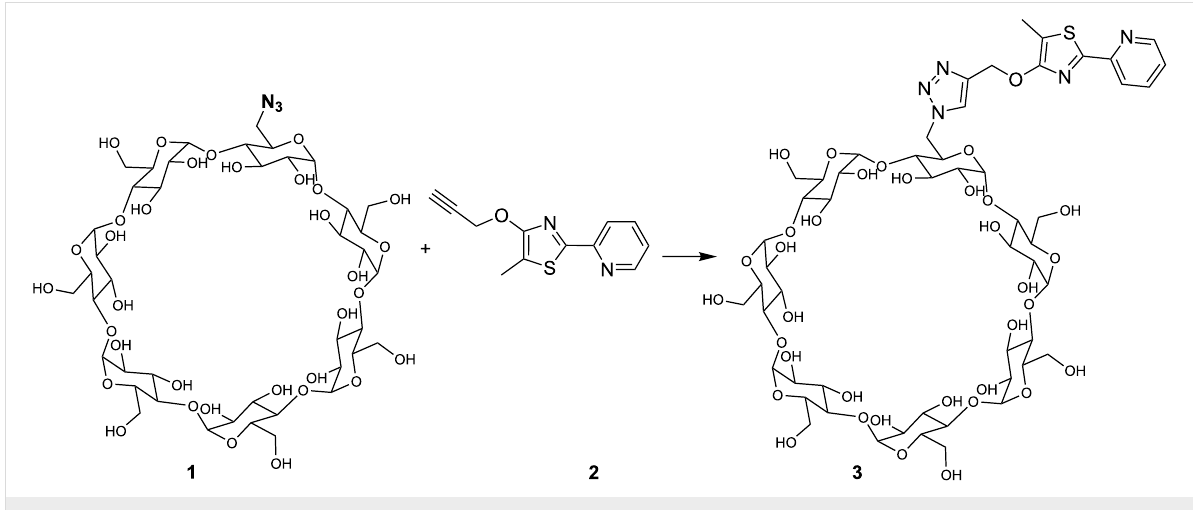
trometry, 1 H NMR and IR spectroscopy. The formation of host–guest structures between the thiazole functionality and β -CD was proven by 1 H NMR rotating-frame Overhauser effect spectroscopy (ROESY) (Figure 1). NOE correlation signals of the β -CD cavity protons between 4 and 3.5 ppm and the aromatic protons of the pyridine moiety 8.6–7.4 ppm were observed, clearly proving the formation of